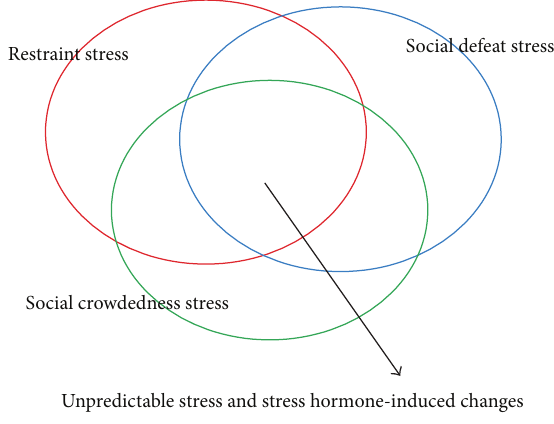
Figure 1: A schematic diagram illustrating that some stress-induced alterations may be heritable, but others may not